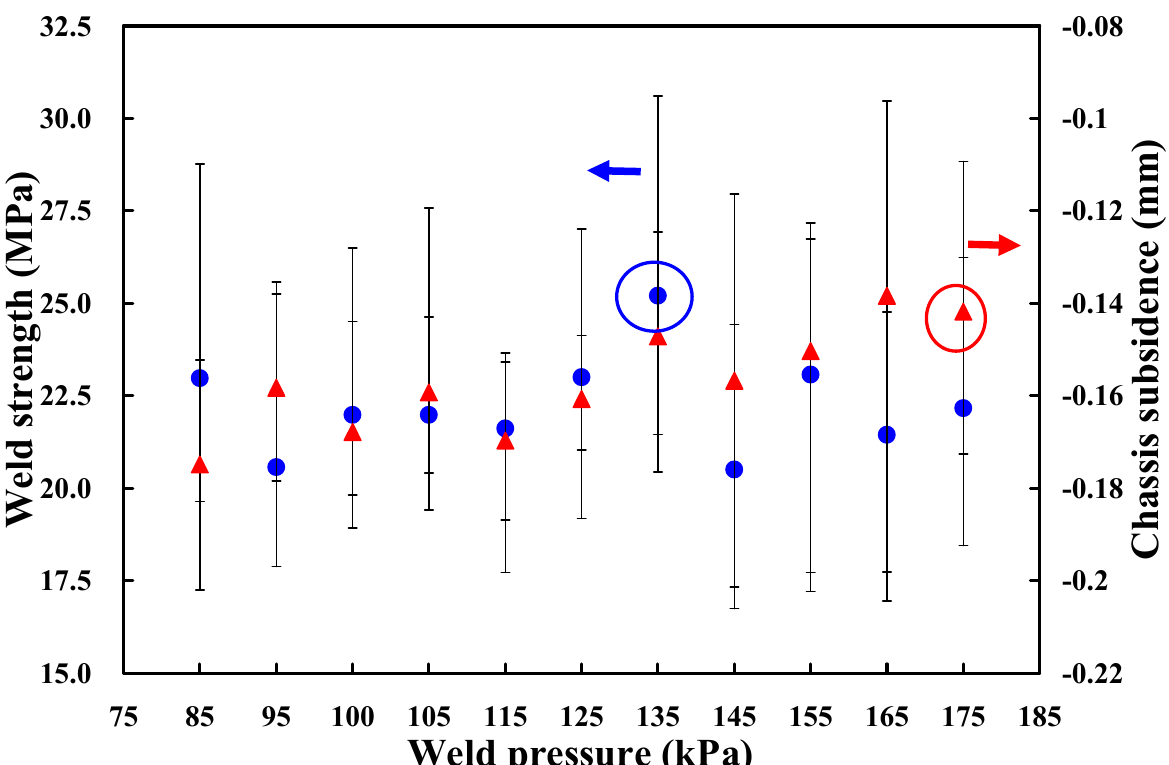
Figure 7. Effects of different weld pressures on weld strength and chassis subsidence.